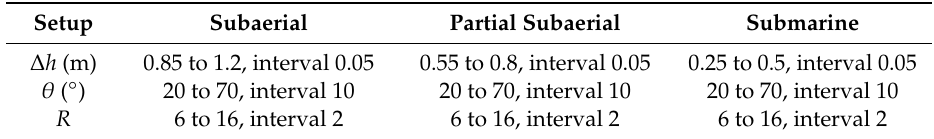
Table 1. The parameter setup for all simulation runs.